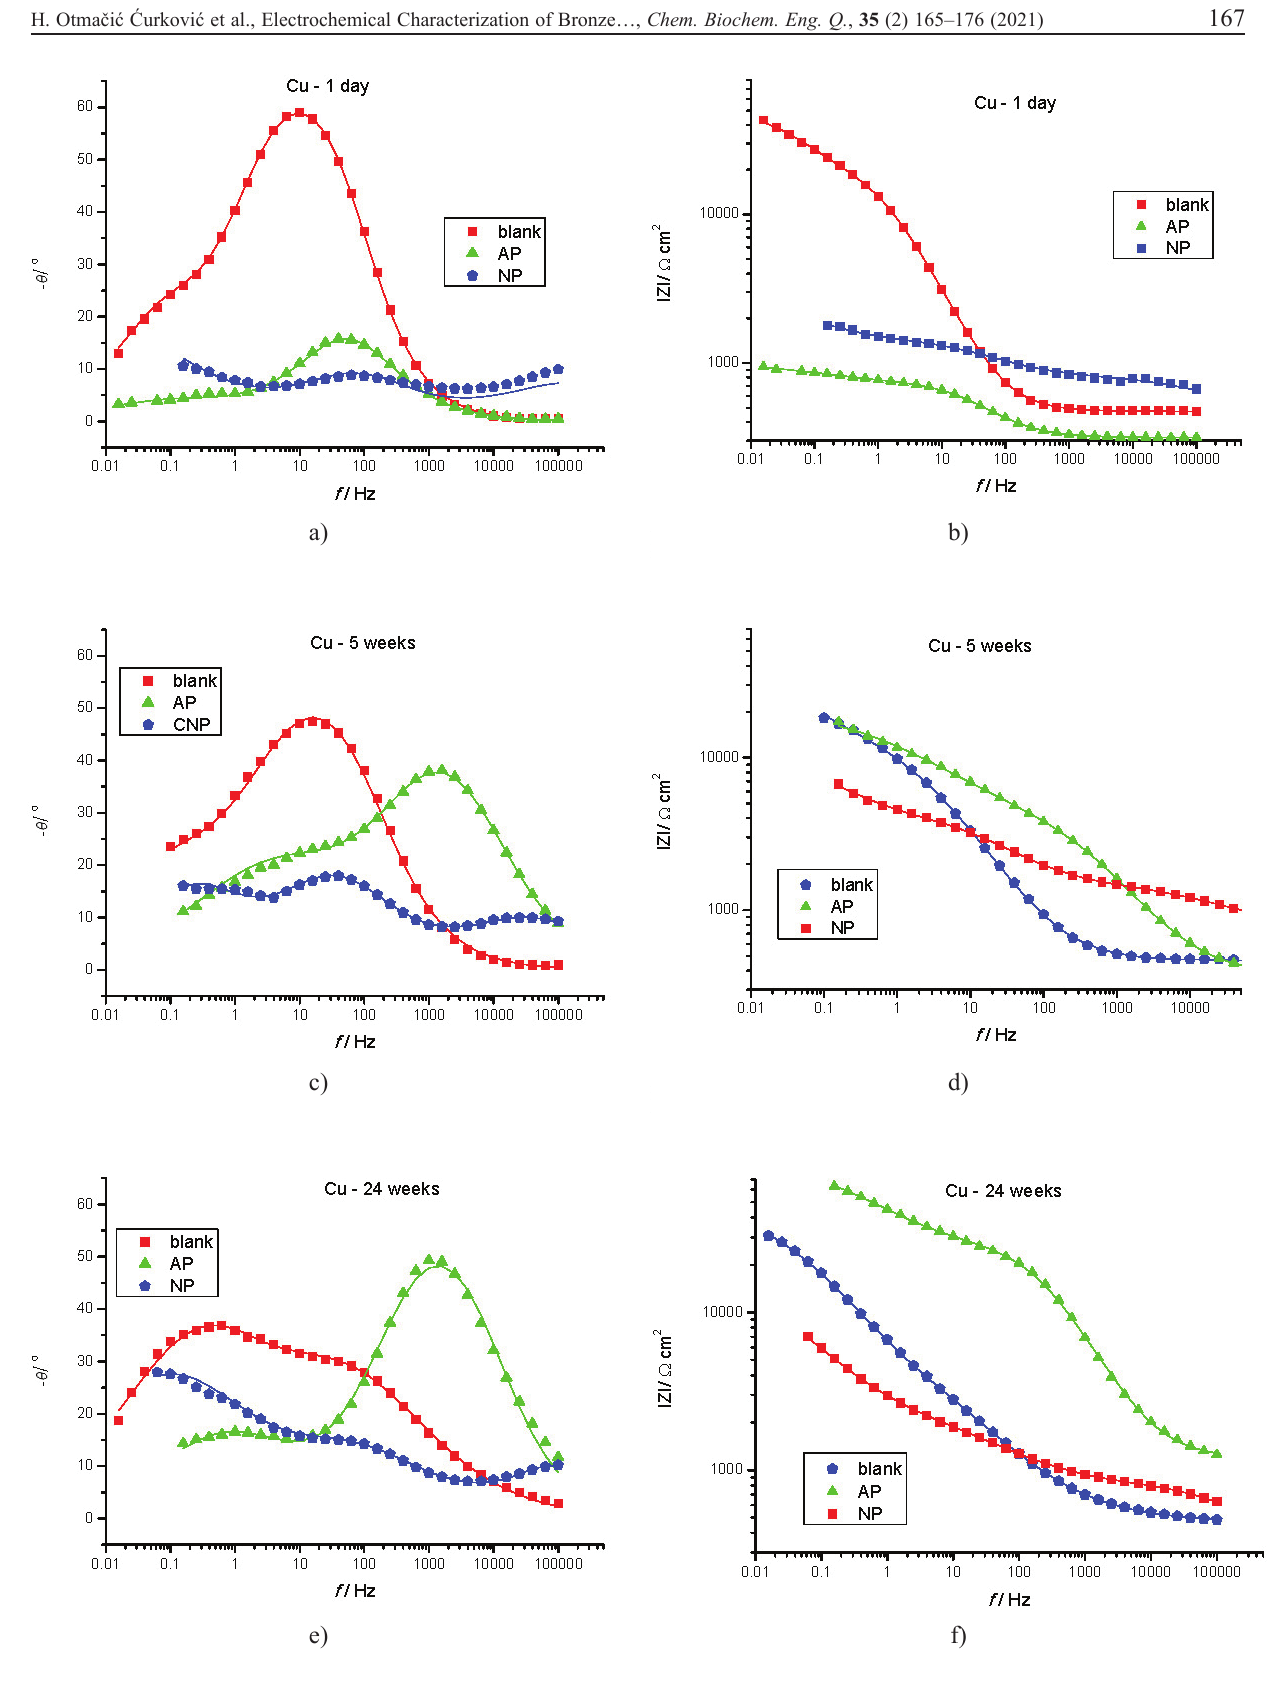
Fig. 1 – Bode impedance plots for blank and patinated Cu samples collected after different periods of exposure to outdoor atmo-